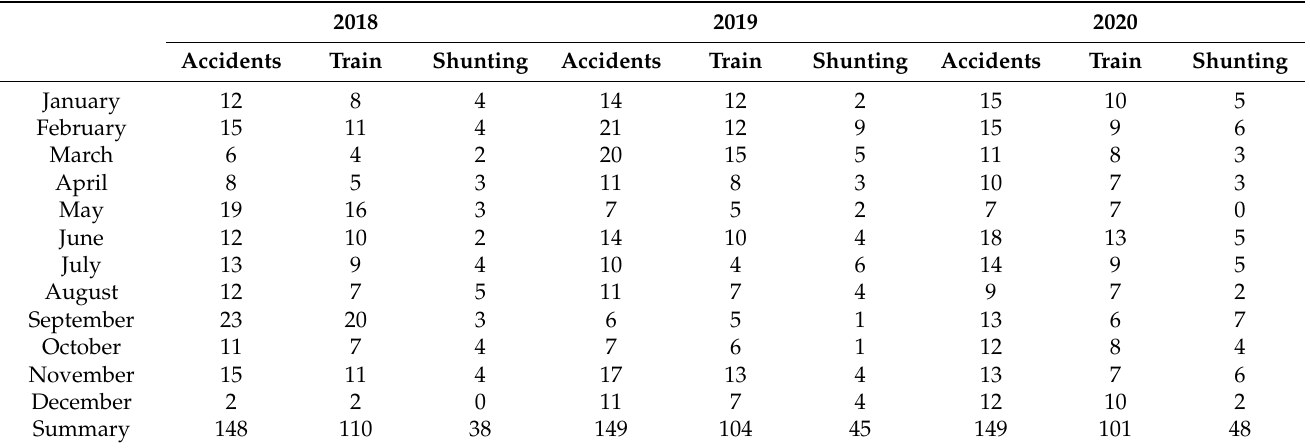
Table 1. Unauthorized driving (violation of traffic signs) through the stop signal, including subse- quent collision or derailment on sidings, regional, and national lines